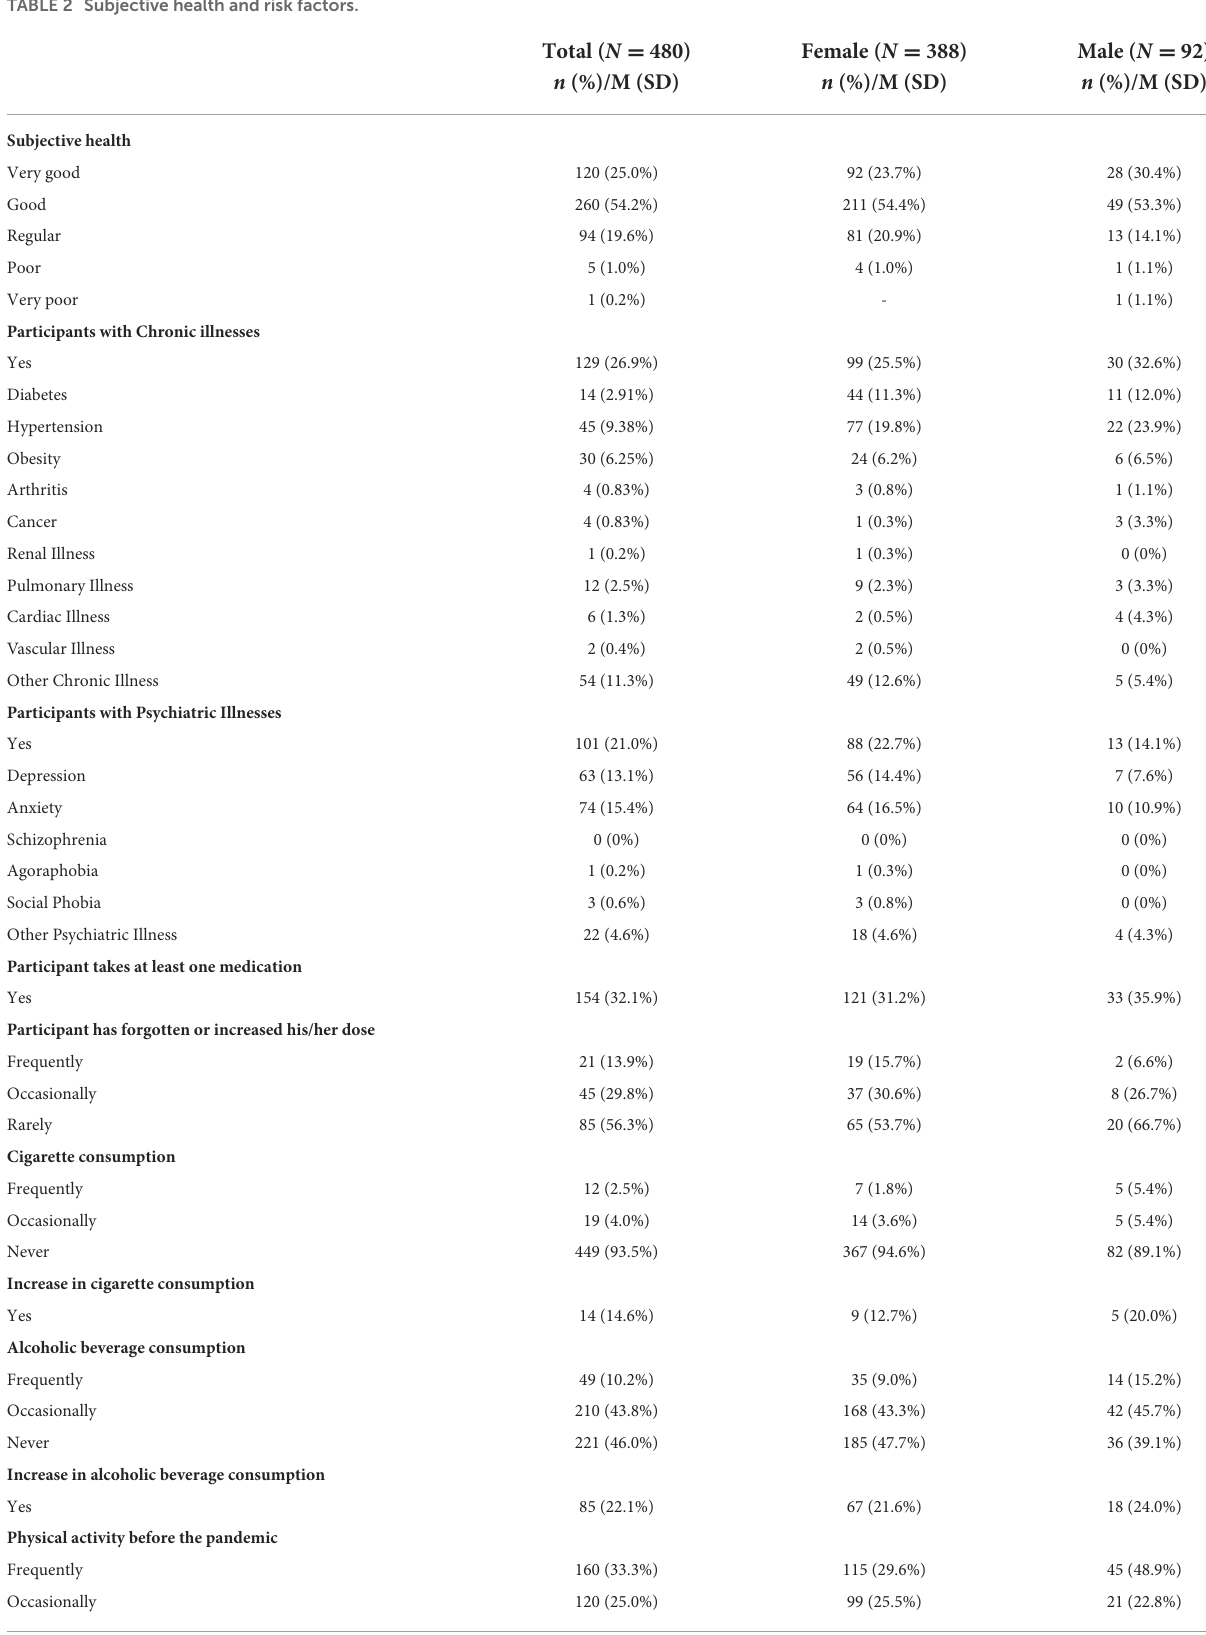
TABLE 2 Subjective health and risk